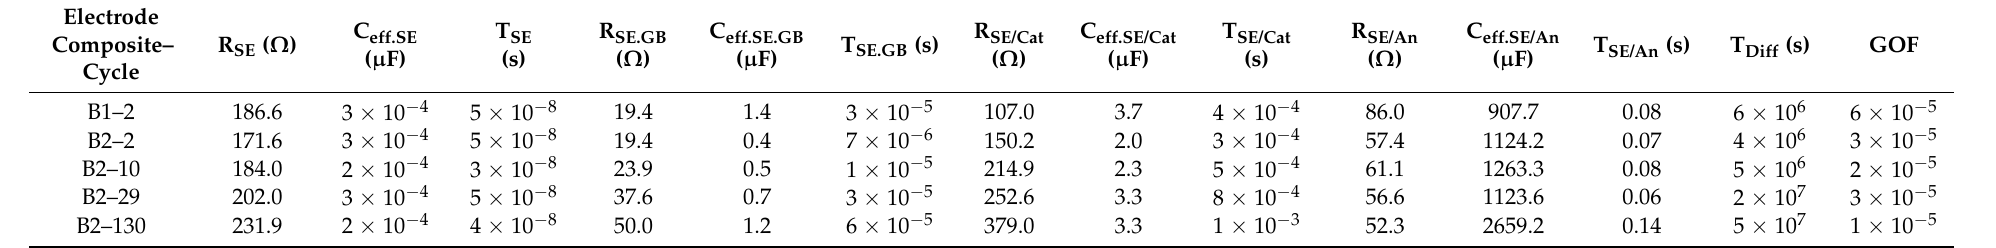
Table 3. Fitting results of impedance spectra (Figure 7) with composite electrodes with LSPCl solid electrolytes prepared via solution process at different charge cycles. GOF: goodness of fit (discrepancy between model and experimental values of impedance spectra).